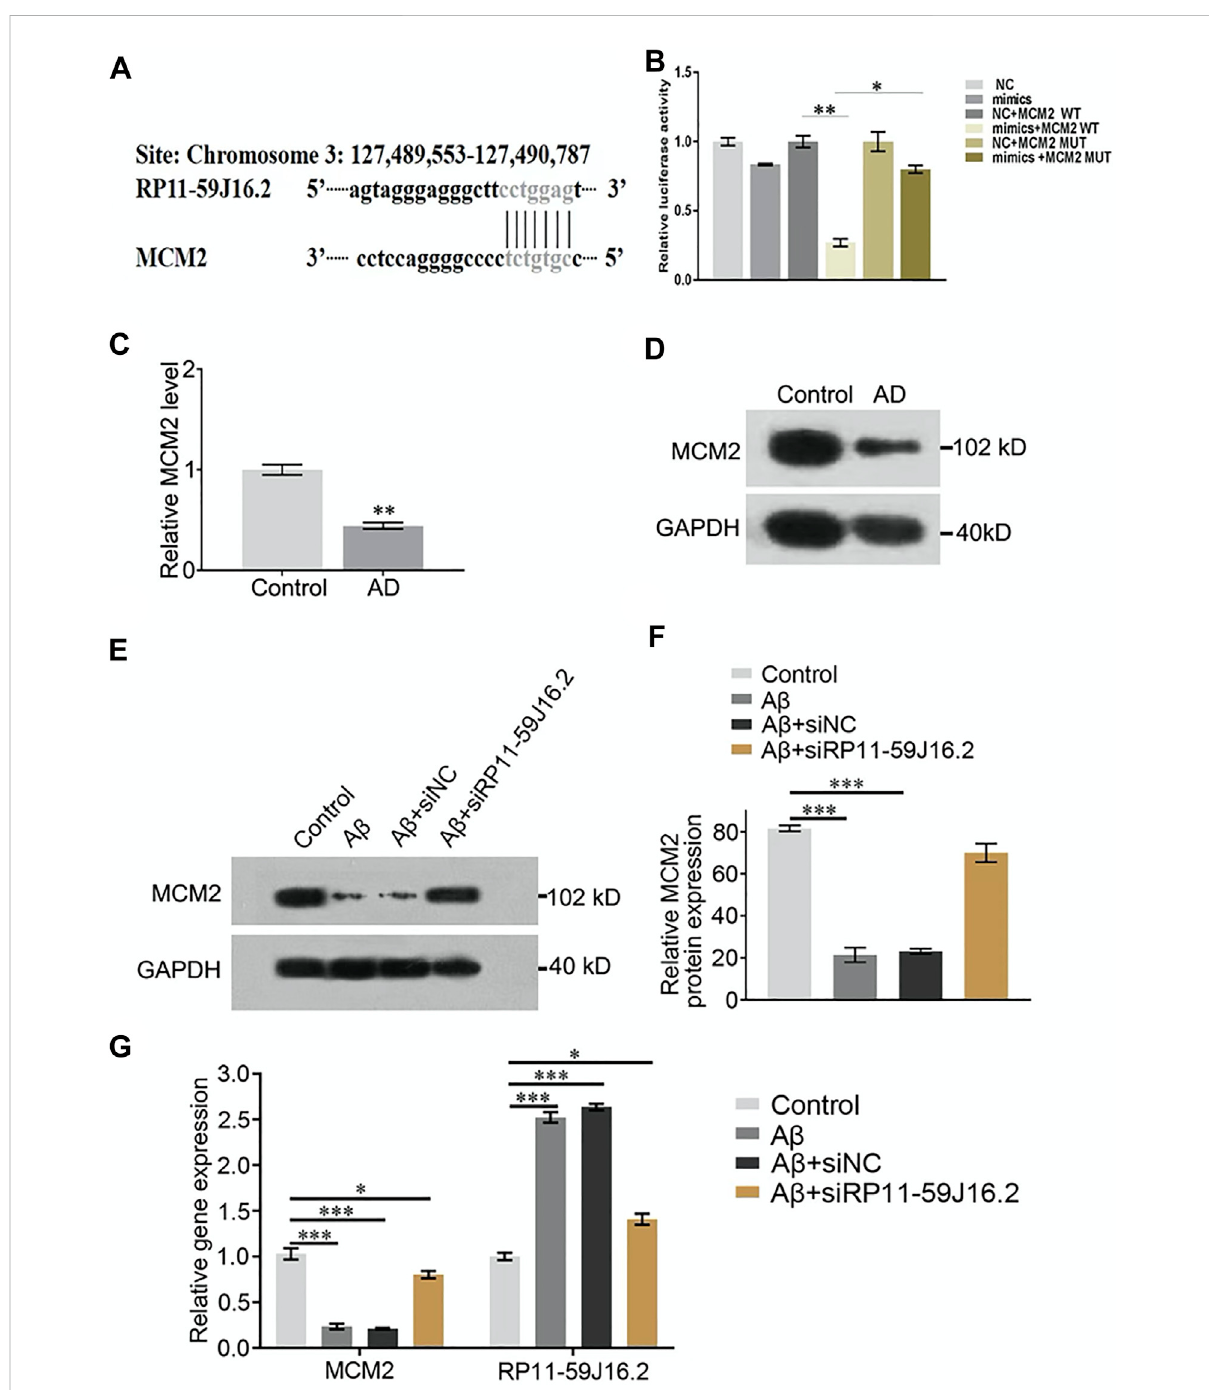
RP11-59J16.2 target regulate the expression of MCM2 which was low expressed AD serum and cell model. (A) Bioinformatics analysis of the binding sites of RP11-59J16.2 and MCM2. (B) Double luciferase reporter gene assay veri fi ed the binding sites of RP11-59J16.2 and MCM2. (C,D) Low expression of MCM2 in serum of AD patients by qRT-PCR and Western blot. (E,F) MCM2 was low expressed and inhibitedby RP11-59J16.2 in AD cell model. (G) qRT-PCR con fi rmed high expression of RP11-59J16.2 and low expression of MCM2 with positive correlation in AD cell model. The experiment was repeated three times in each group, * p < 0.05; ** p < 0.01, *** p <